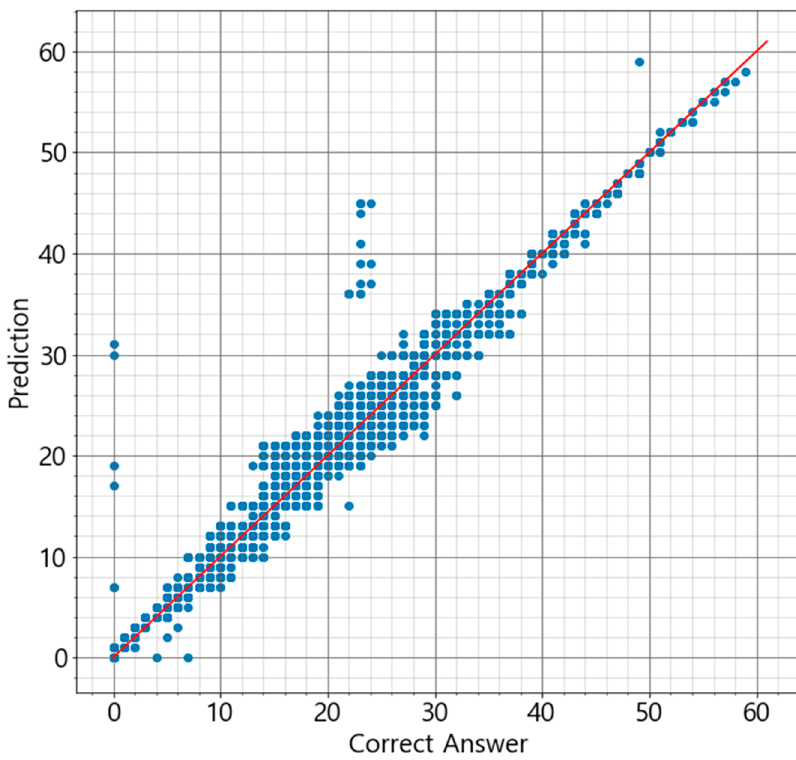
Figure 20. Prediction of sap amount based on ANN.